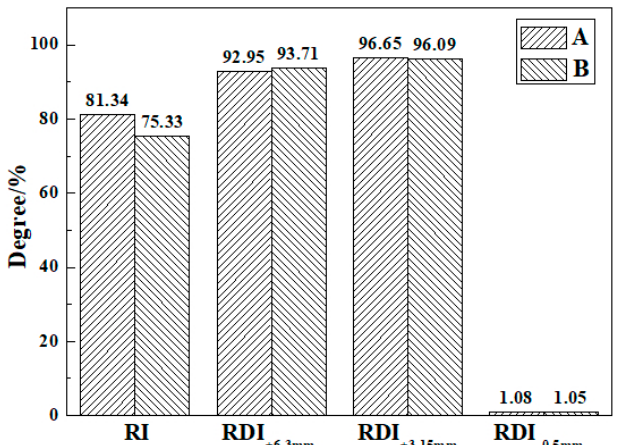
Figure 4. Metallurgical performance of the product sinter of different sintering processes ( A ) Traditional sintering process, ( B ) Pressurized densification sintering process.